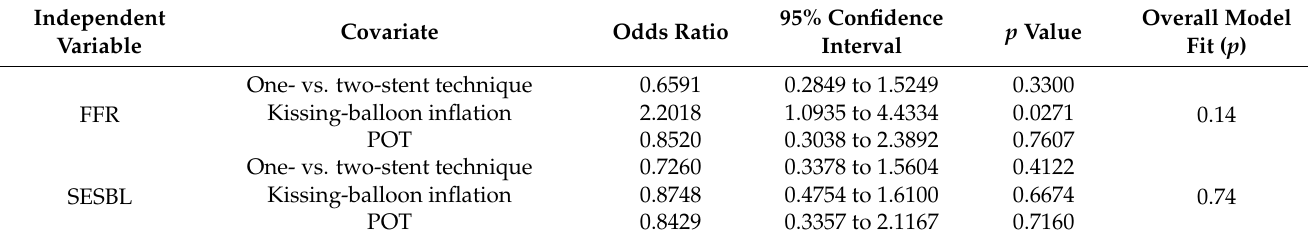
Table 4. Logistic regression analysis for each technique and FFR >0.8/SESBL